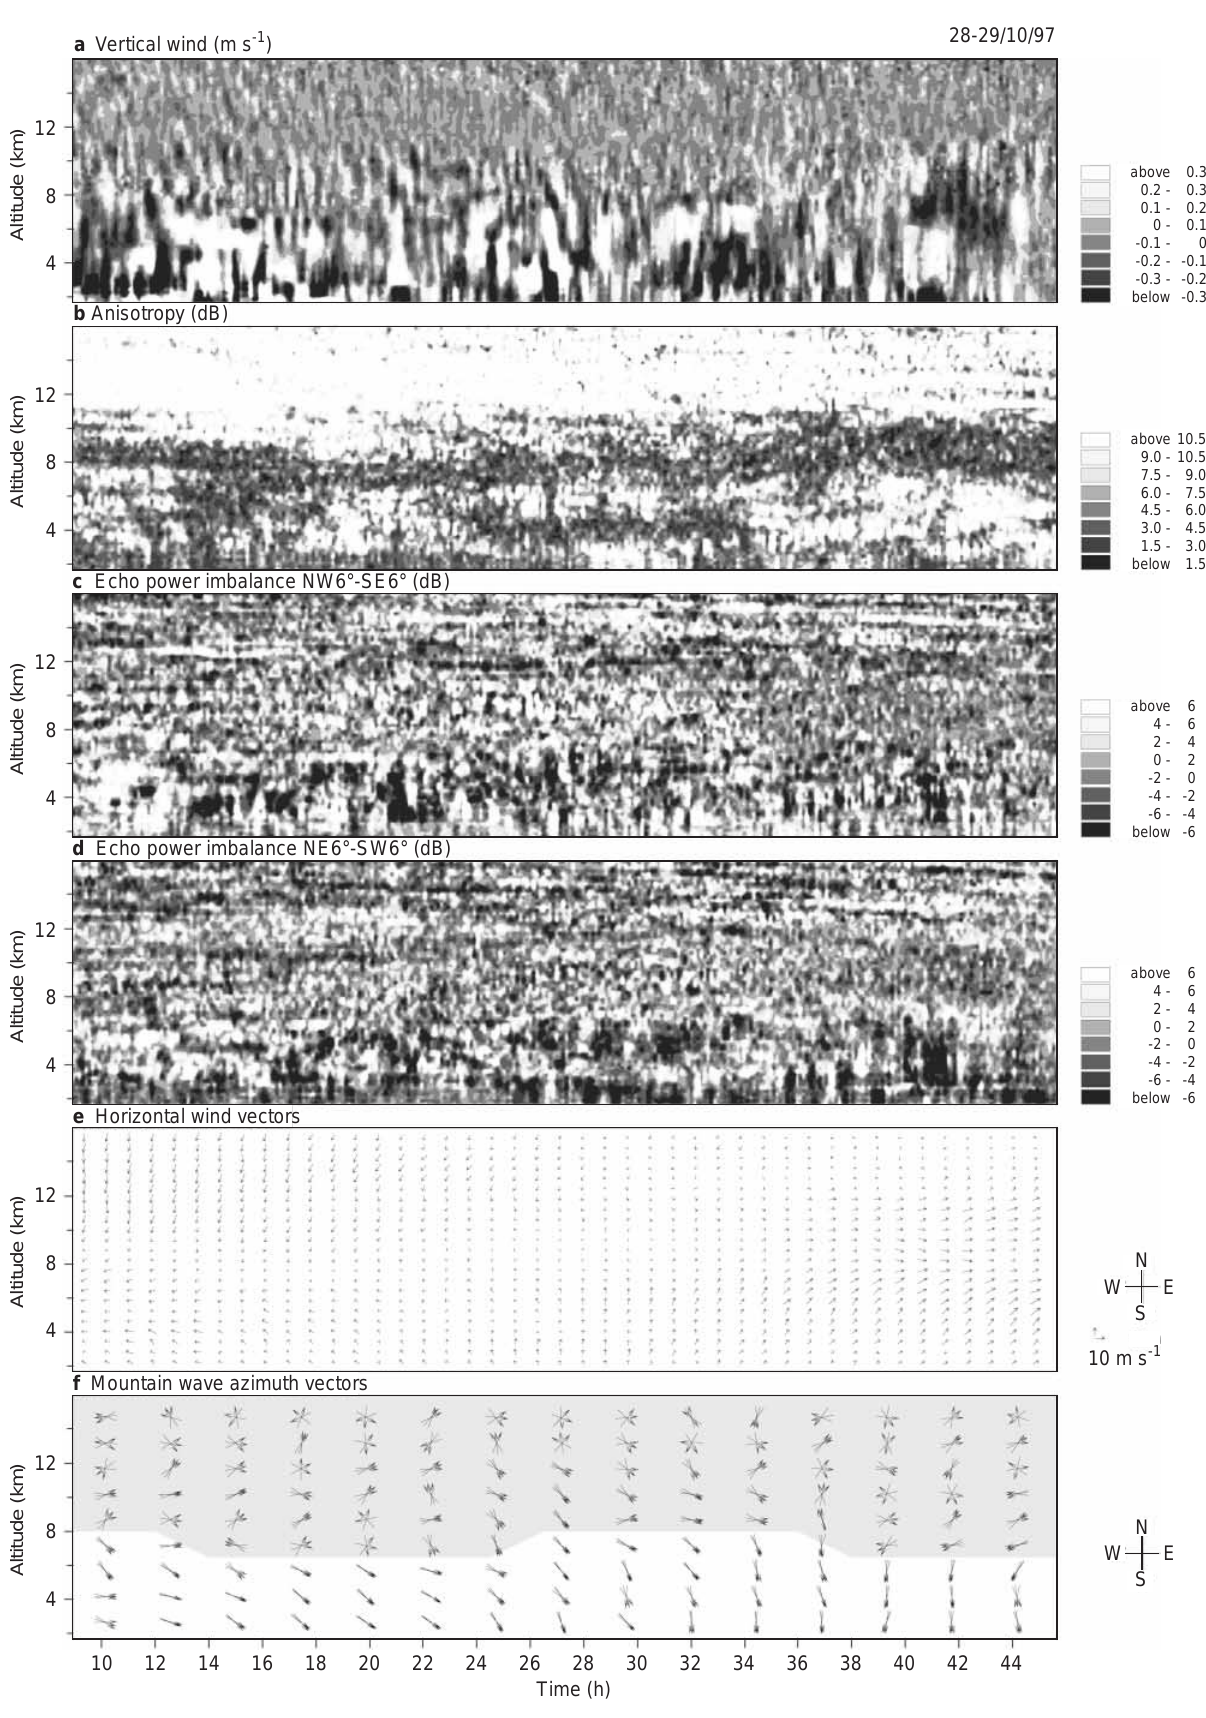
Fig. 8. As Fig. 4, for 28–29 October